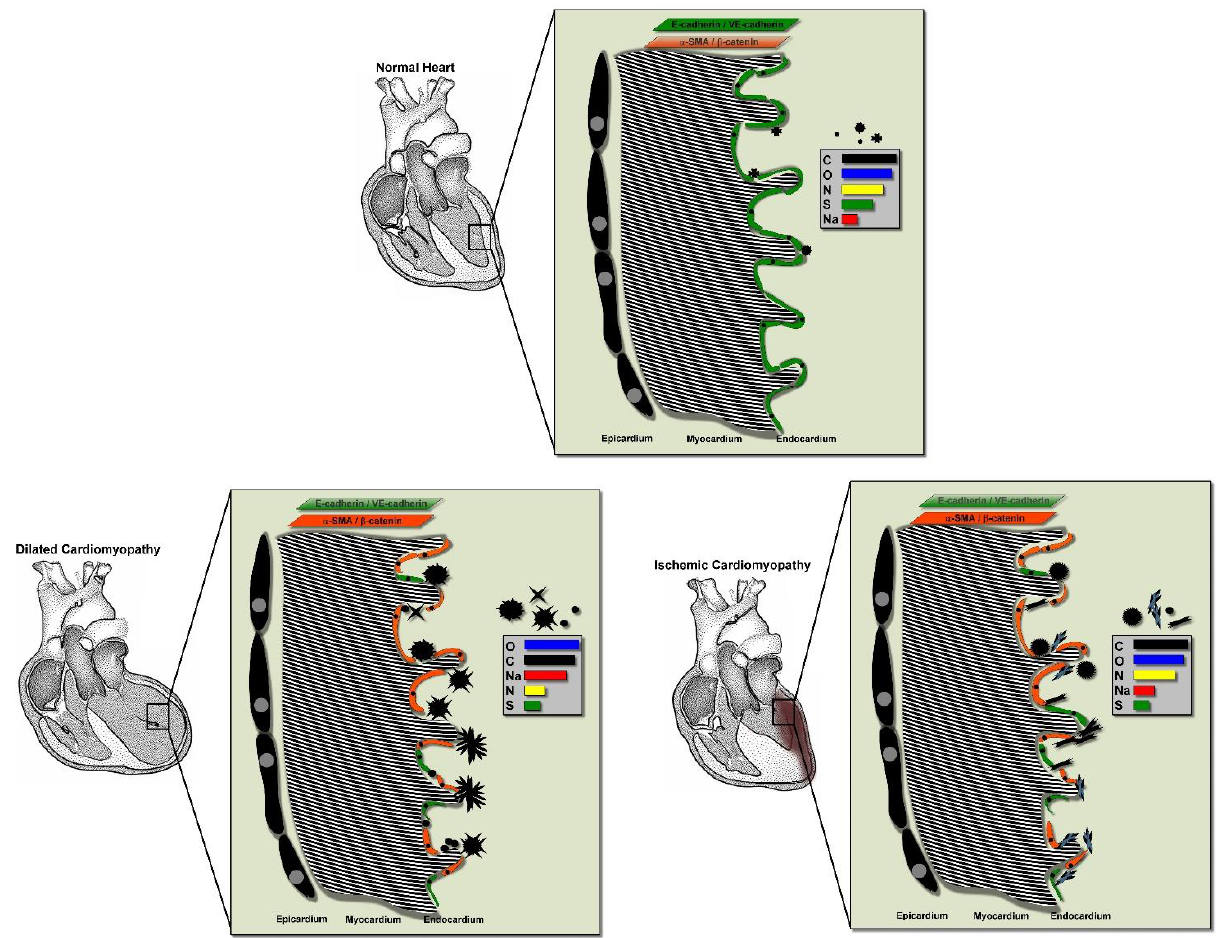
Figure 7. Schematic representation of the mechanism of HF-induced composite accumulation in the endocardium. In a normal heart, the endocardium is integrated and smooth, and the number of composites is small. In the HF group, the endocardium is damaged and EndMT is induced. The fragmented myocardial fibers and various types of deposits are intertwined and stacked on top of the endocardium.